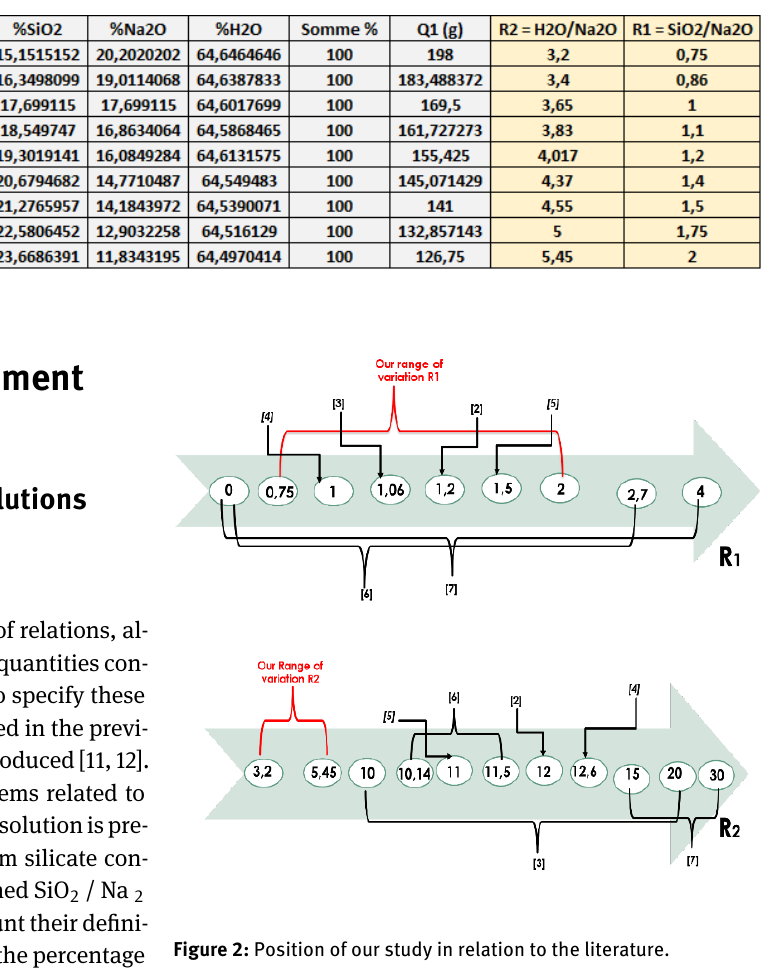
Table 1: Formulation of activation solution.